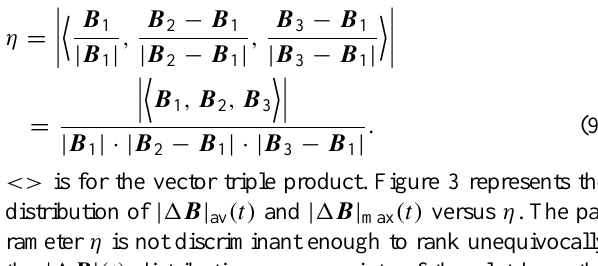
Fig. 4. Normalized histograms of the observed errors for CLF observatory during 1999: the maximal possible error for εb =0.75, 1, 2nT.